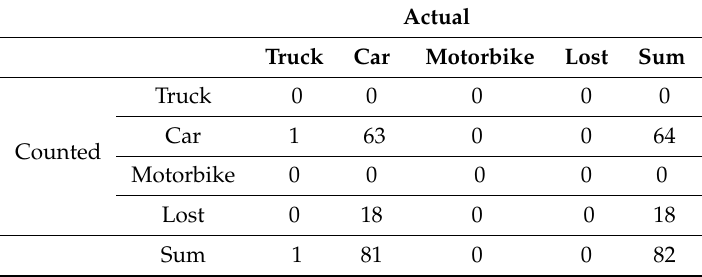
Table 4. Counting results per vehicle type from a toll station with 1000 ms request